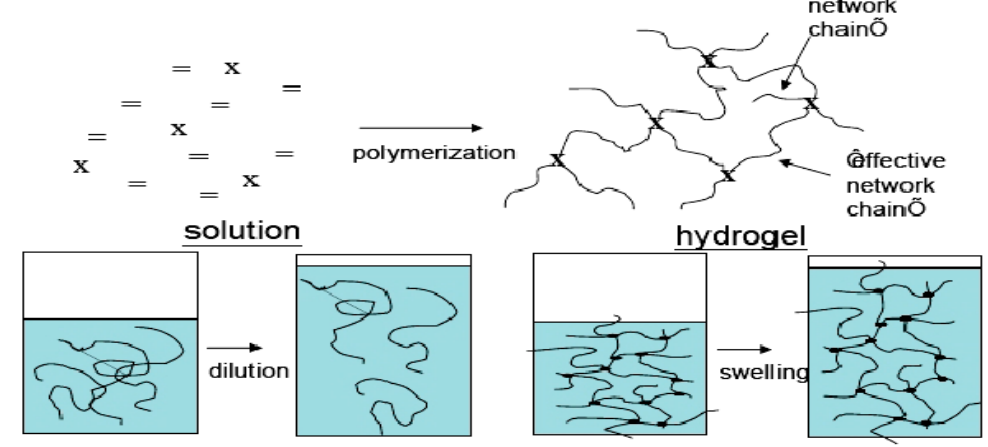
Fig. 1. Schematic feature of chemical hydrogels formation